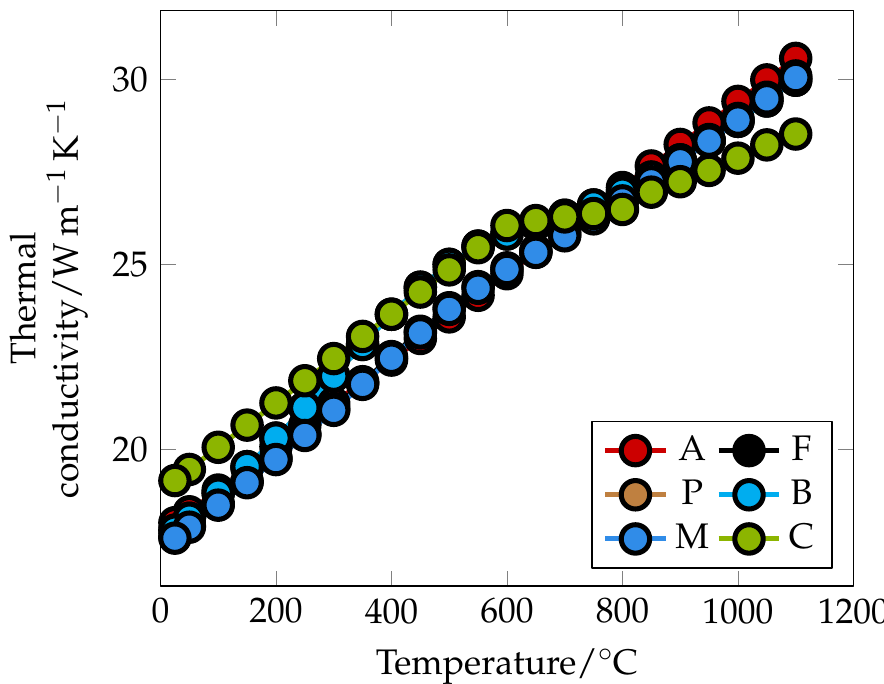
Figure 7. Thermal conductivity of different phases of X30Cr13 calculated by JMatPro ® . The abbrevia-